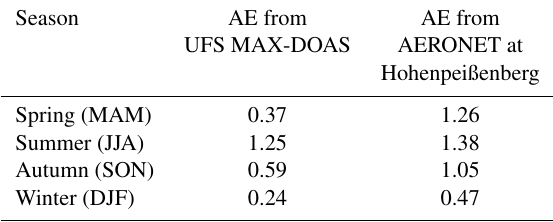
Table 8. Seasonal average Ångström exponents (AEs) obtained from MAX-DOAS near-surface measurements (0–0.5km above in- strument) and from AERONET measurements at Hohenpeißen- berg. The results of the MAX-DOAS are calculated from the ra- tios between the seasonal average aerosol extinction coefficients at 360 and 477nm (i.e., the ratios shown in Fig. 16). The results of AERONET are the seasonal average values of AEs (380–500nm) at Hohenpeißenberg from April 2013 to February 2016.